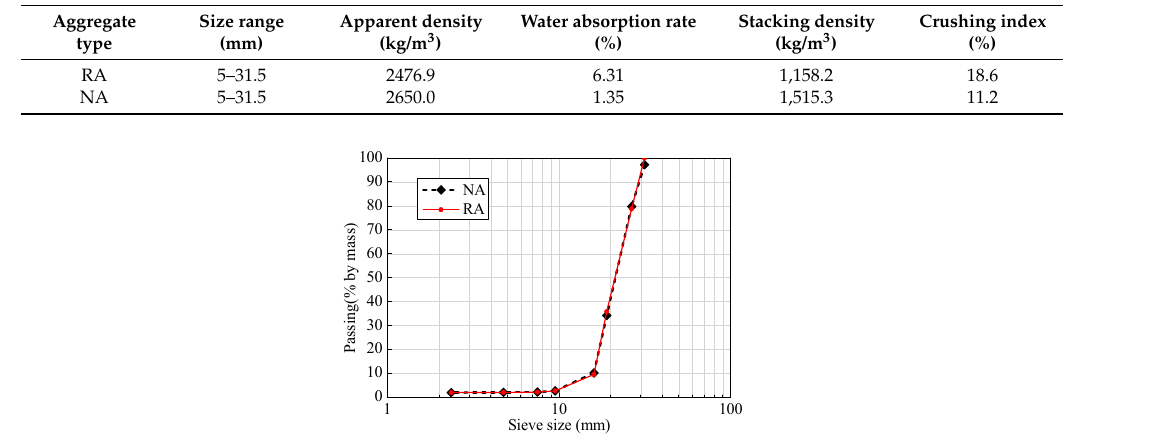
Table 1. Properties of coarse aggregate.